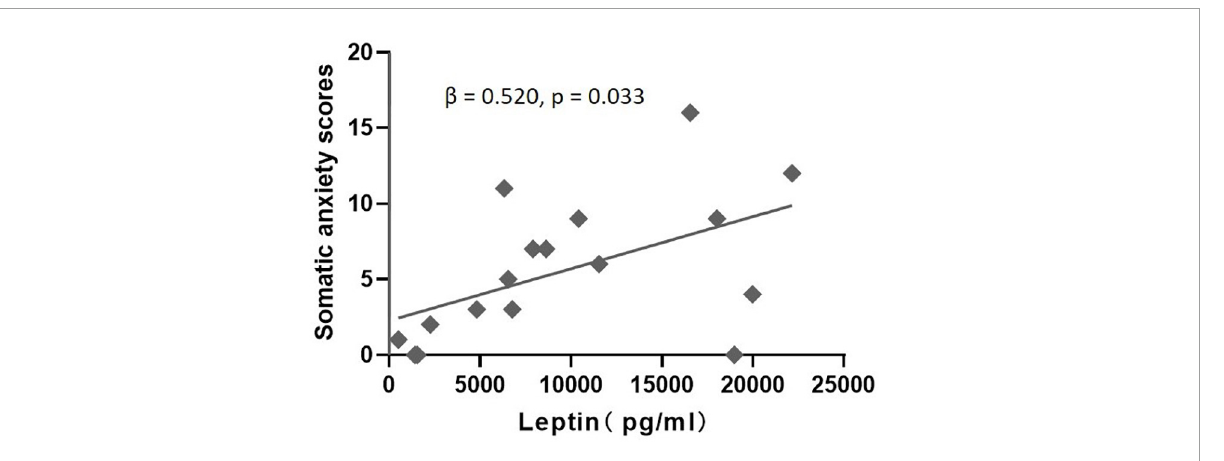
FIGURE2 Multiple regression analysis to examine the effect of leptin on somatic anxiety scores after accounting for age, gender, and BMI in the MDD